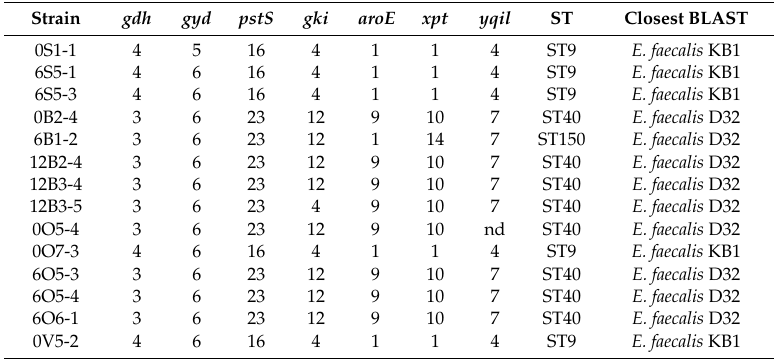
Table 1. Alleles and multilocus sequence type adscription for each studied